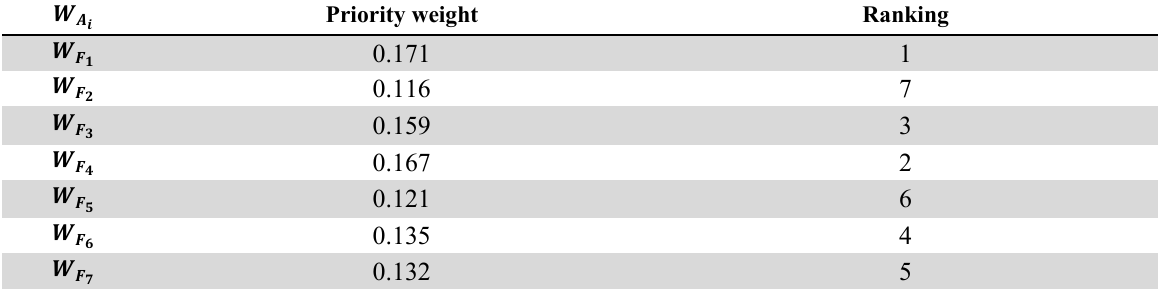
Priority weight for the lean practice